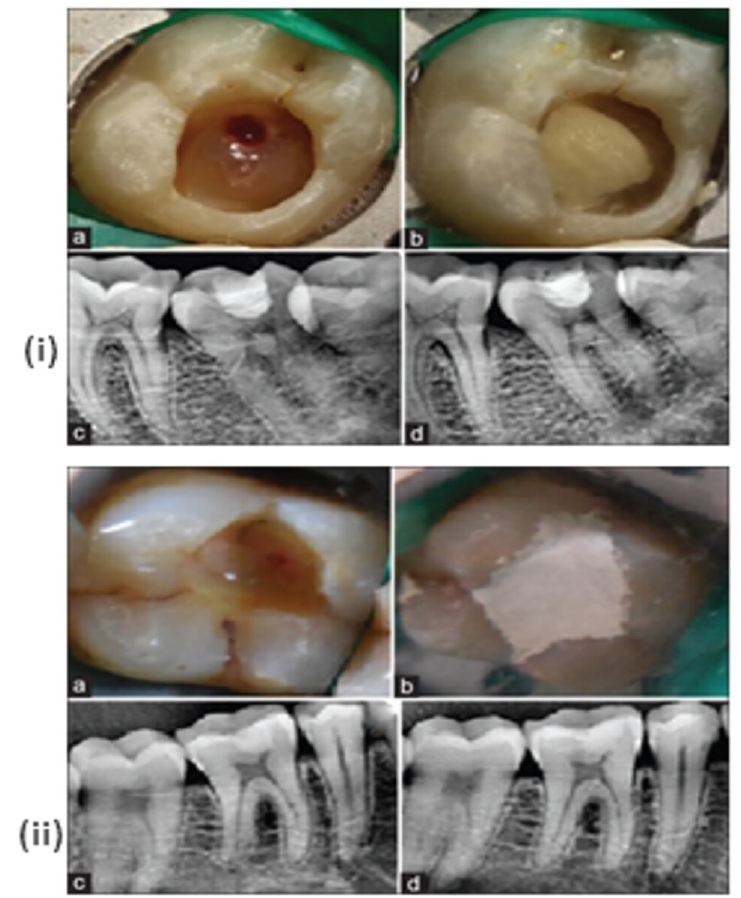
Figure 12. ( i ) (a) Exposure of pulp after caries excavation; (b) Placement of MTA over the exposed pulp; (c) Radiographic image showing placement of the MTA after pulp capping; (d) Follow-up radiograph after 6 months; ( ii ) (a) Exposure of pulp after caries excavation; (b) Placement of Biodentine over the exposed pulp; (c) Radiographic image showing placement of the Biodentine after pulp capping; (d) Follow-up radiograph after 6 months [215].